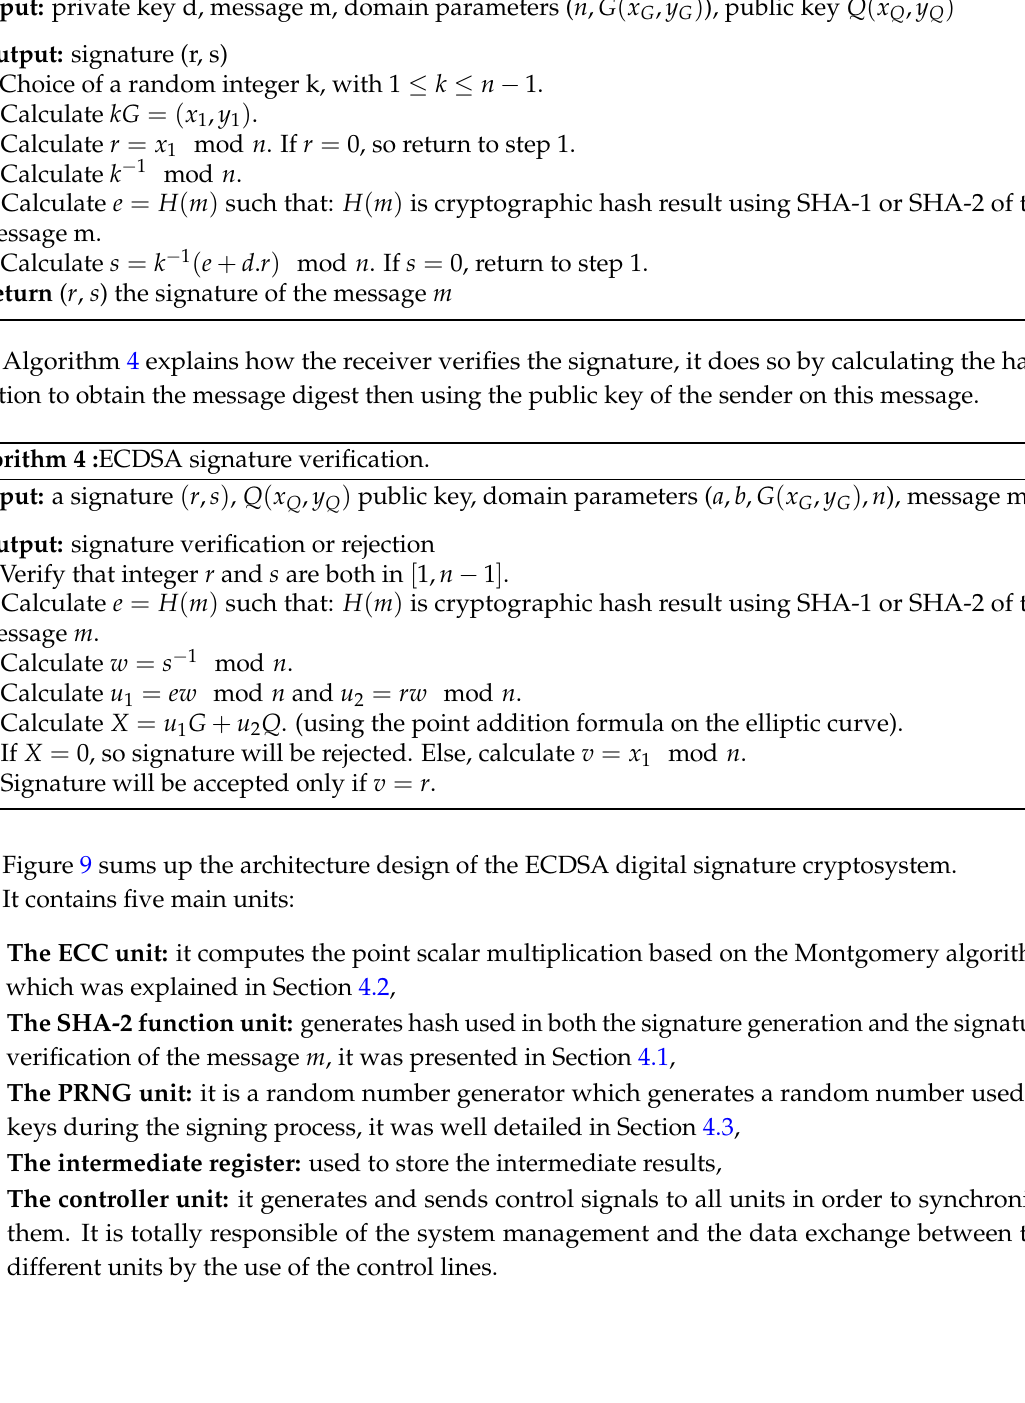
Algorithm 3 : ECDSA Signature Generation.